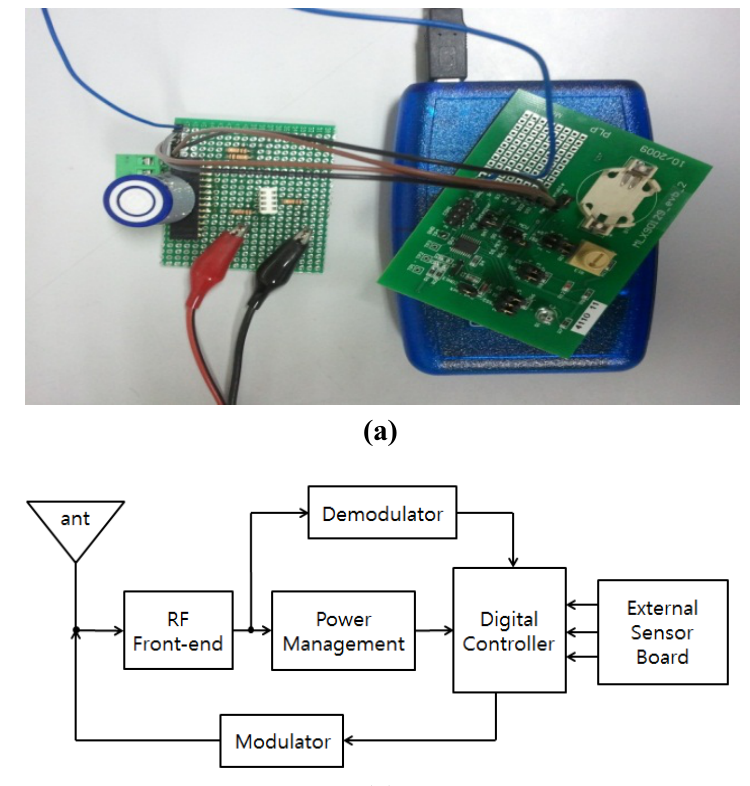
Figure 1. Measurement system configuration based on EVB 90129. (a) Picture. (b) Block